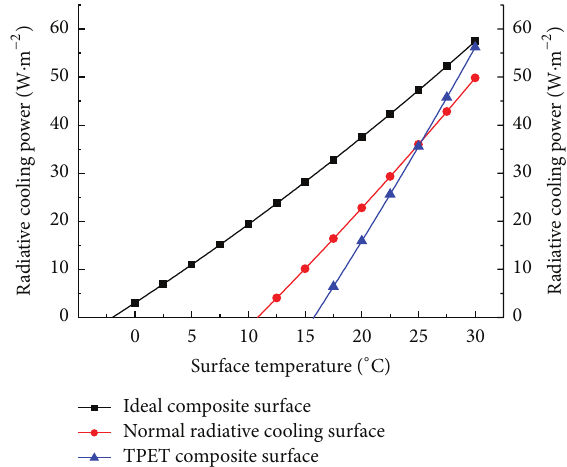
Figure 9: Change in radiative cooling power of the three kinds of radiative cooling surfaces with surface temperatures at ambient temperature of 30 ∘